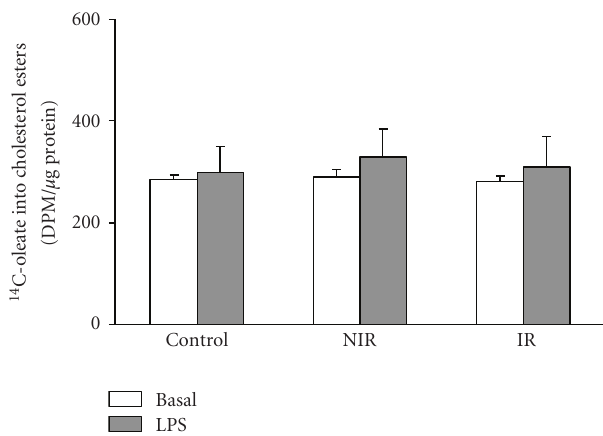
Figure 4: Cholesterol esterification in LPS-activated monocytes from PCOS and control girls. Each value represents mean ± SEM of 8 separated